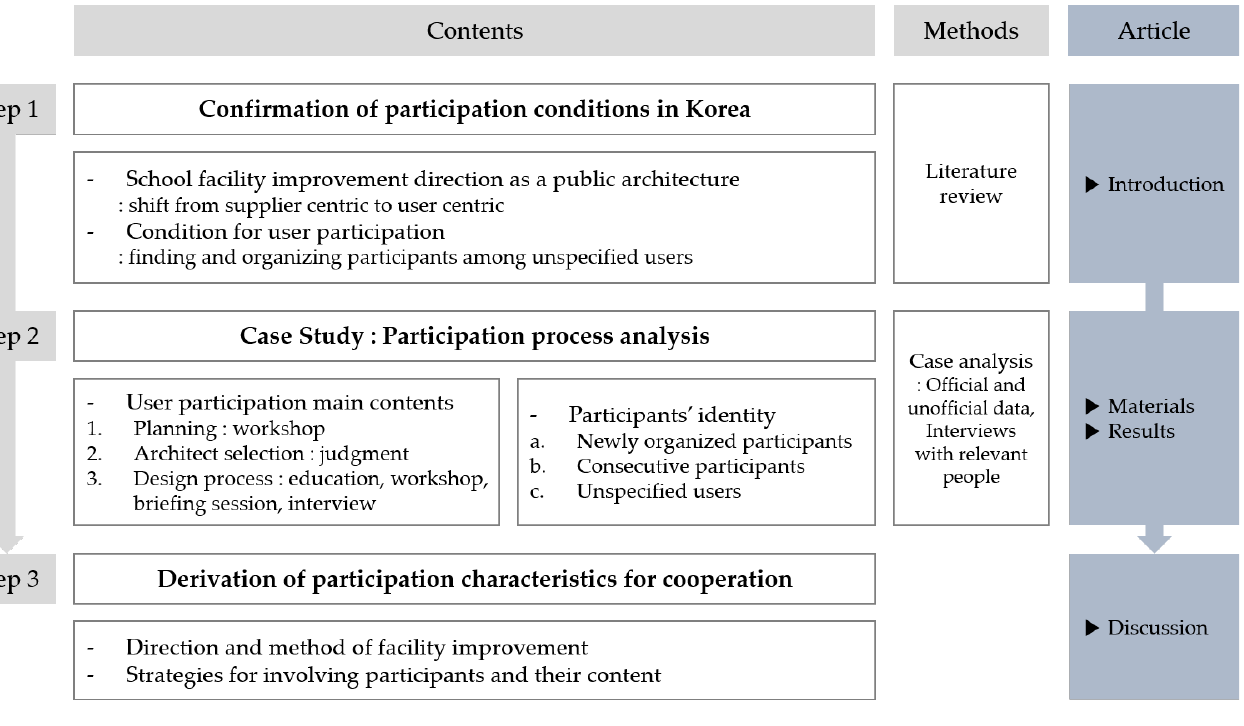
Figure 3. Research flow and